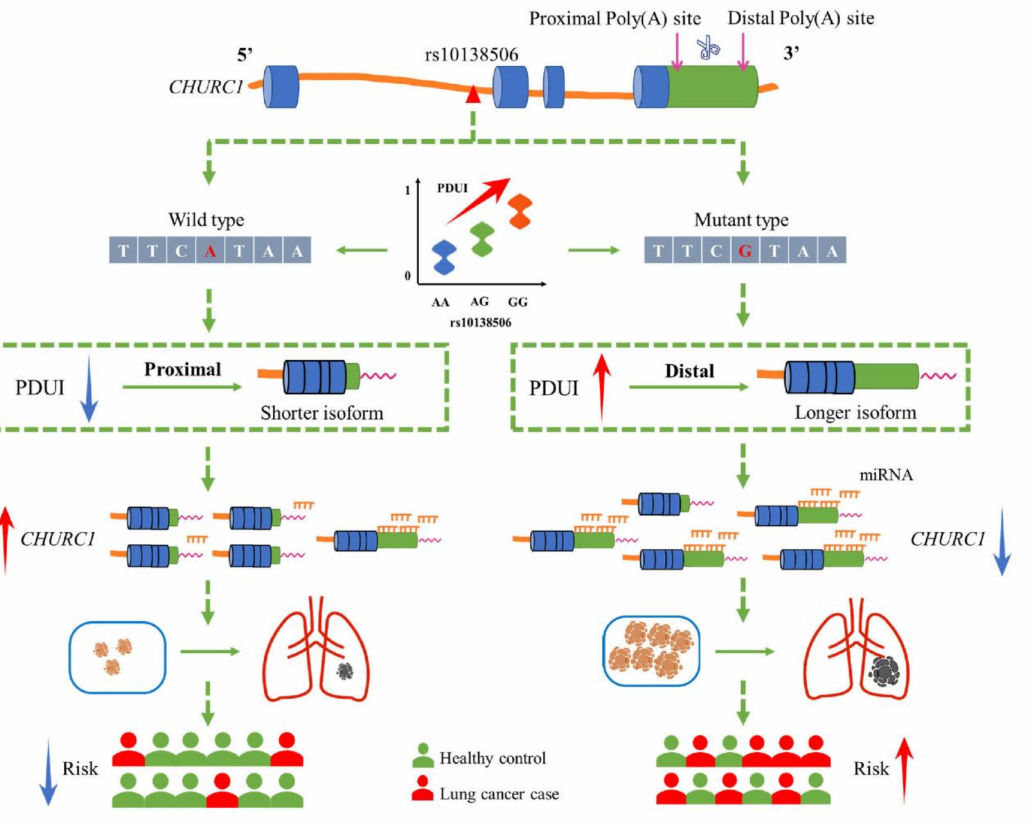
Figure 6. The potential regulation mechanism of apaQTL-SNP rs10138506 mediating malignant pheno- typic changes in LUAD by regulating the 3 (cid:48) UTR length of CHURC1 . apaQTL, alternative polyadenylation quantitative trait loci; SNP, single nucleotide polymorphisms; 3 (cid:48) UTR, 3 (cid:48) untranslated region; LUAD, lung adenocarcinoma; PDUI, percentage of distal poly(A) site usage index; miRNA,